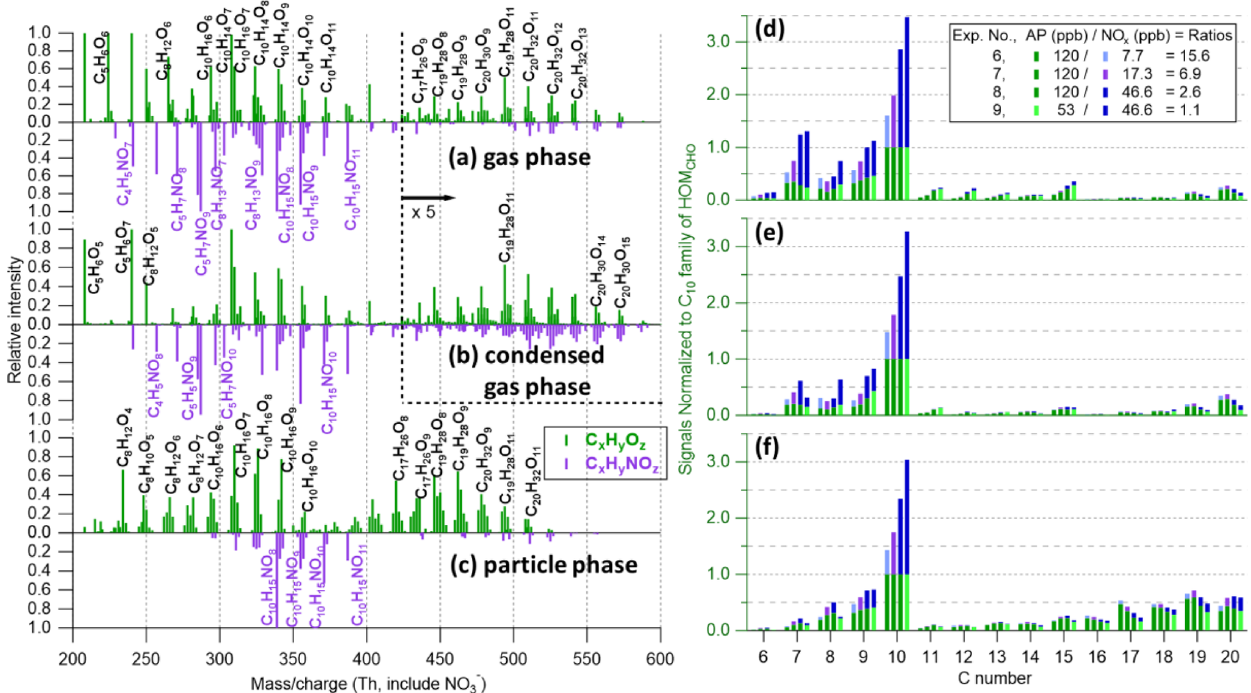
Figure 6. (a–c) Mass spectra of (a) gas-phase (without seed), (b) condensed-gas-phase (from the difference between spectra without and with seed particles), and (c) particle-phase (at 230 ◦ C) measurements from experiment no. 7 (input flow condition of 120ppb α -pinene, 33ppb O 3 , and 17.3ppb NO 2 with UV lights on). Gas-phase and condensed-gas-phase mass spectra (30min average) are normalized to (C 10 H 14 O 7 )NO 3 at m/z 308 with m/z 240, and/or m/z 208 and m/z 224, off the scale, with peaks larger than 420Th being multiplied by a factor of 5. Particle-phase mass spectra (60min average) are normalized to (C 10 H 16 O 7 )NO 3 at m/z 310 with m/z 339 off the scale. Nitrogen-containing ions (C x H y NO z , i.e., HOM ON ) are plotted downward, while the other ions are plotted upwards. (d–f) The distribution of HOM products (varying initial α -pinene to NO x ratios from 15.6 to 1.1), grouped by carbon numbers, in the (d) gas phase, (e) condensed gas phase, and (f) particle phase. Signals are normalized in each experiment to the C 10 family of HOM CHO compounds (green bars), and the blue bars (HOM ON ) are stacked on the top of the HOM CHO